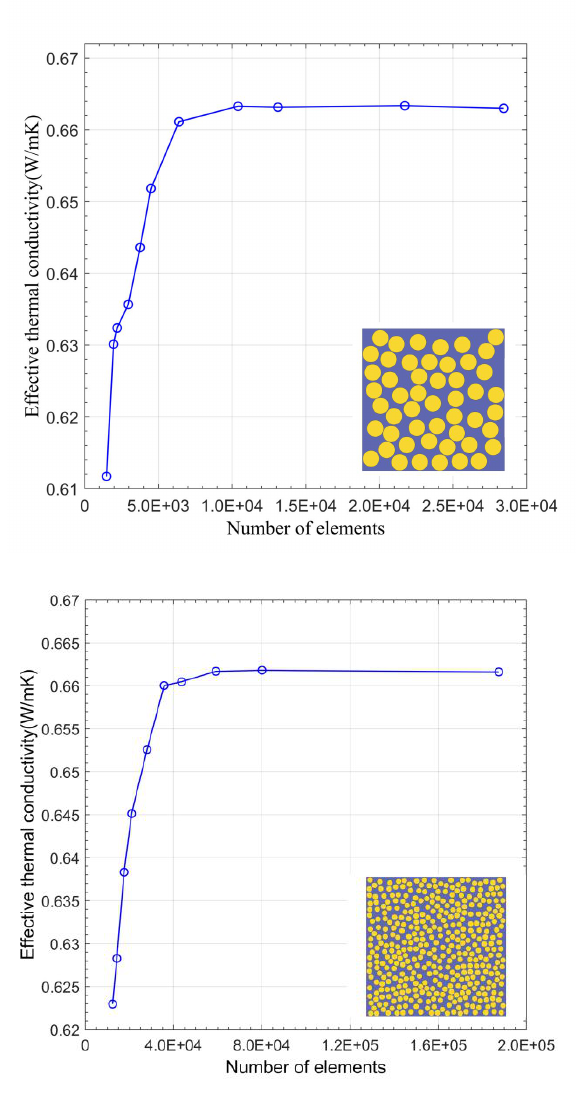
Figure 9: Convergence study for different mesh refinement levels for the composite microstructures with 50 and 400 fibers